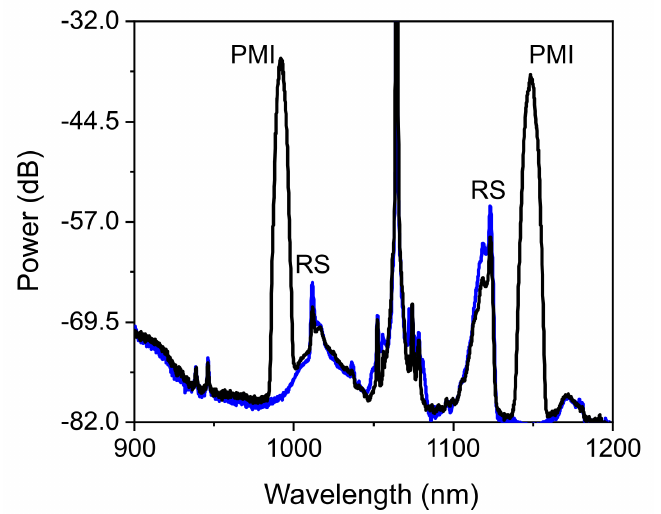
Figure 9. Light spectrum for two orthogonal polarization orientation of the pump. Pump polarization oriented to the fast axis (blue line) and to the slow axis (black line). Both spectra were recorded at pump peak power of 2.4